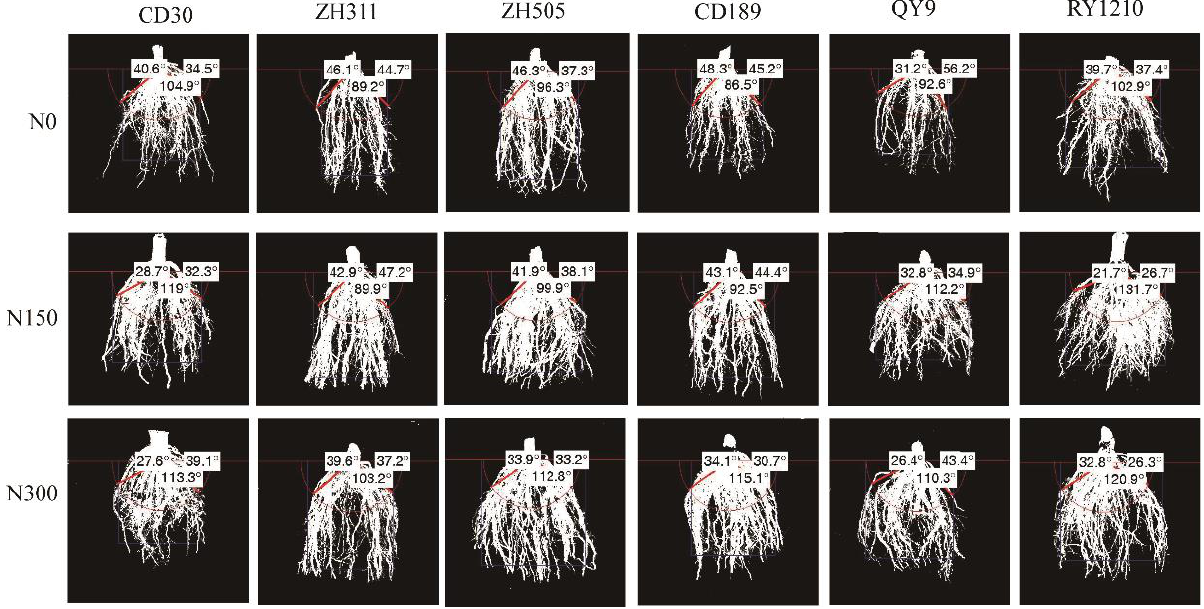
Figure 4. The distribution of the root system of six maize cultivars in three N treatments.